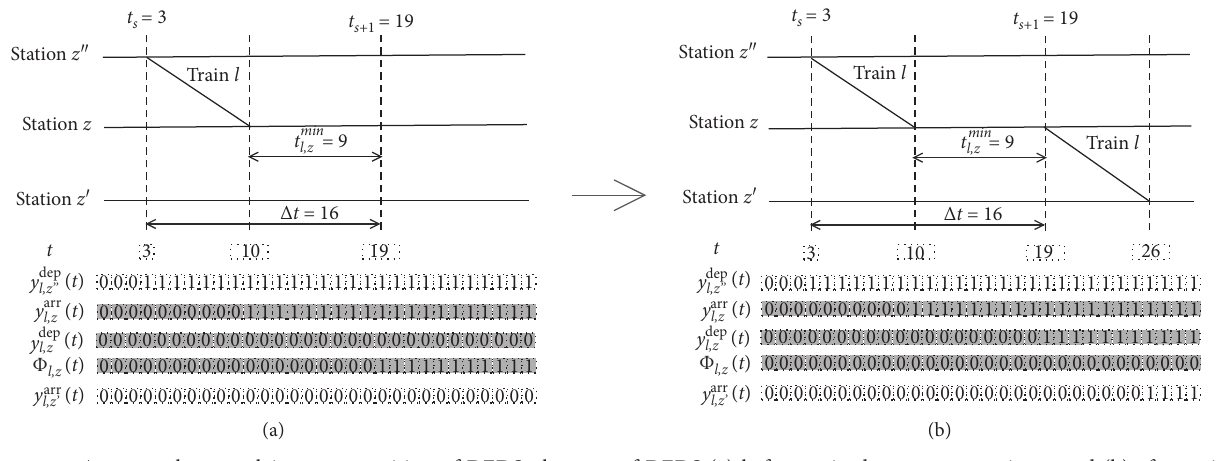
Figure 5: An example to explain state transition of DEDS: the state of DEDS (a) before train departure at station z and (b) after train departure at station z